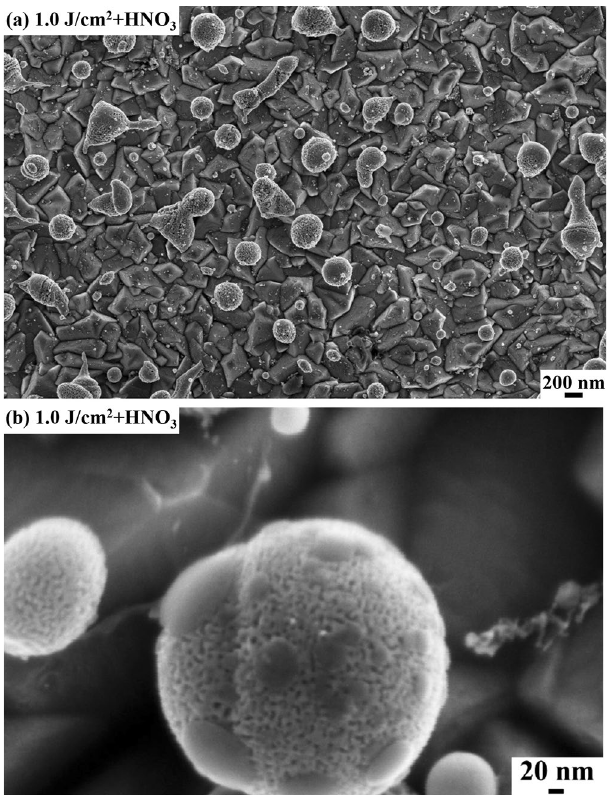
Figure 3. Representative SEM images [with increasing magnification from ( a ) to ( b )] of the nanoporous Au particles obtained by HNO 3 dealloying of the alloy Au–Ag particles obtained on the FTO surface after irradiating the Ag-Au bilayer by laser fluence 1.0 J/cm 2